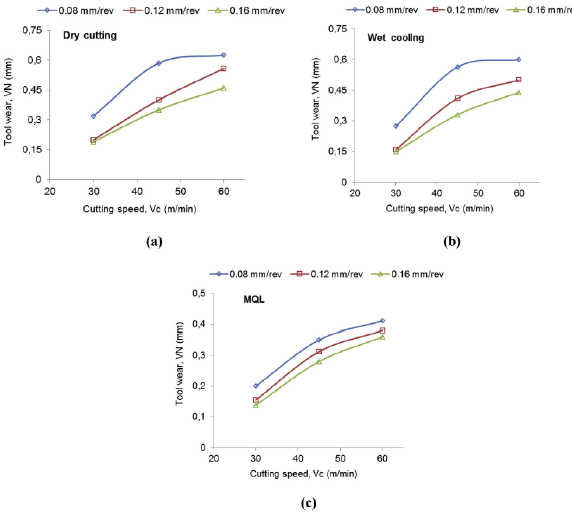
Figure 3: Notch wear of carbide tools vs cutting speed under some cutting conditions; a) Dry cutting, b) Wet cooling, c) MQL